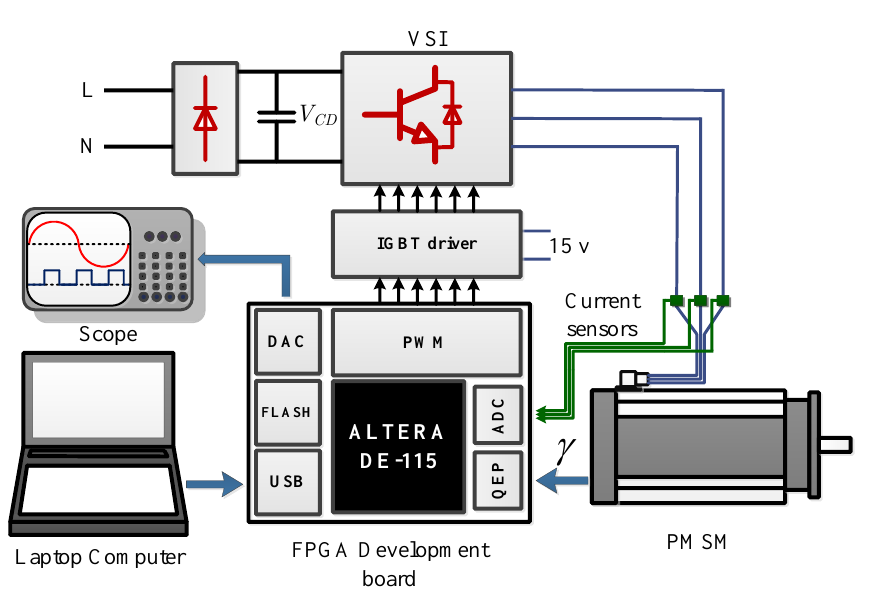
Figure 3. Simplified block diagram of the experimental